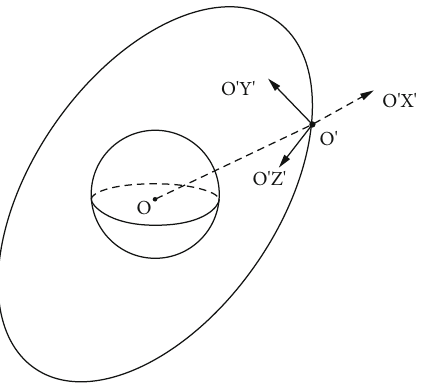
Figure 2: Diagram of the CW coordinate